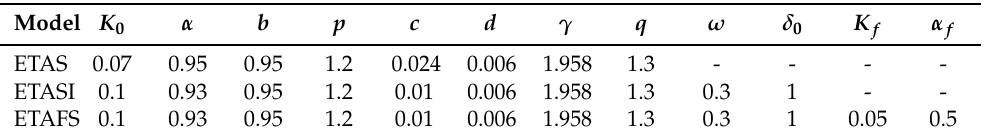
Table 1. Parameters for the three models presented in this study. We consider the lower magnitude threshold m 0 =